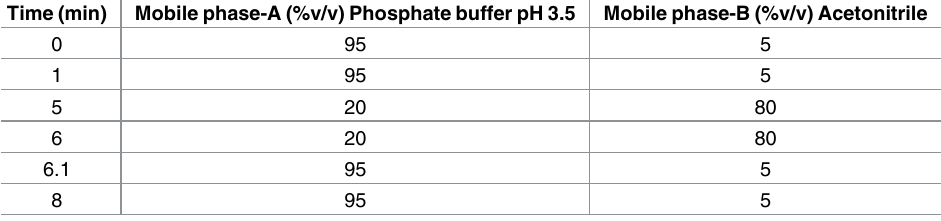
Table 1. Gradient program for the mobile phase during analytical method